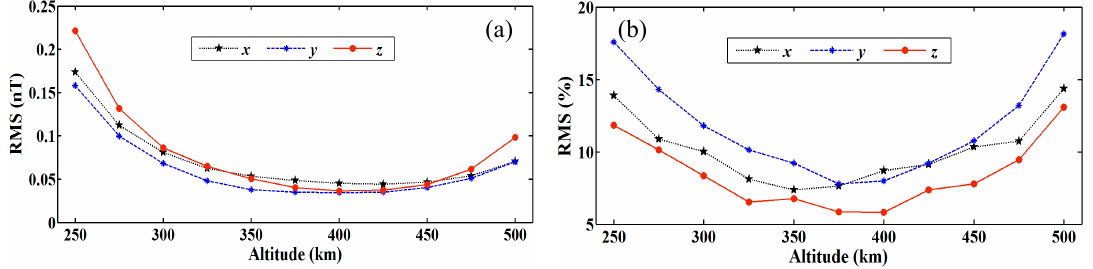
Figure 7. RMS distribution with altitude in nT ( a ) and in% ( b ) for X, Y, and Z components.